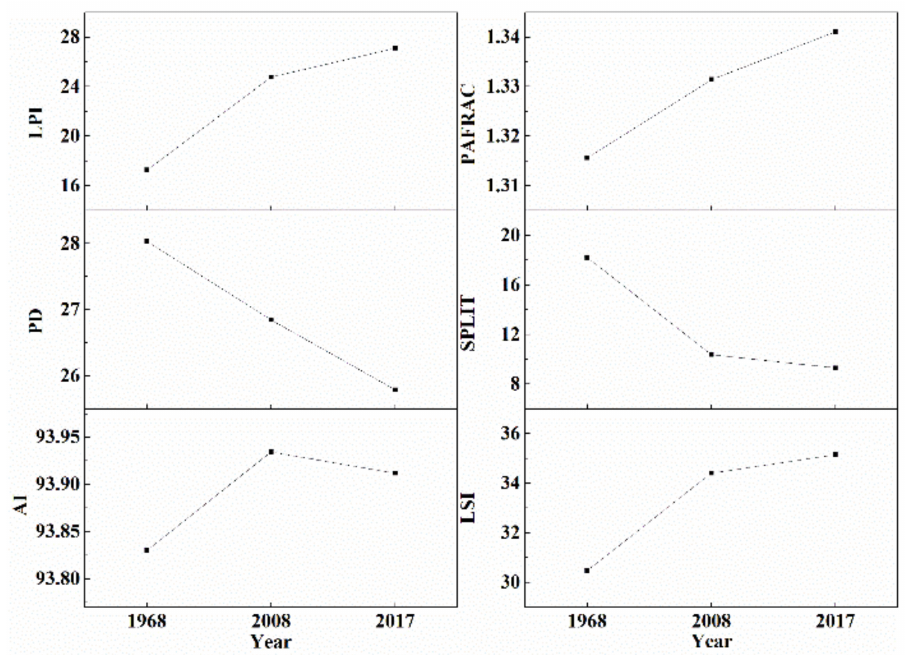
Figure 9. The change of landscape